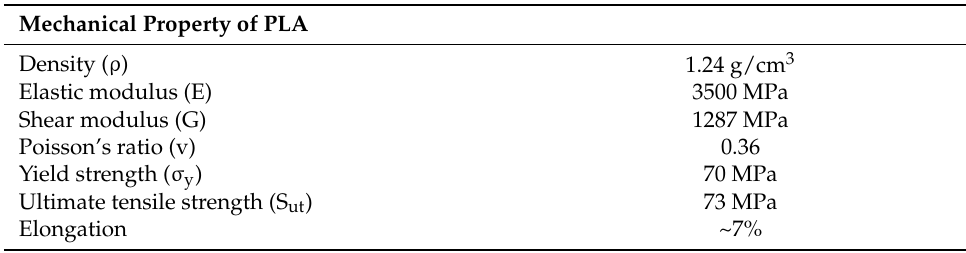
Figure 4. Layer height: 0.12 mm, 0.20 mm and 0.28 mm (left to right). Table 2. PLA material properties